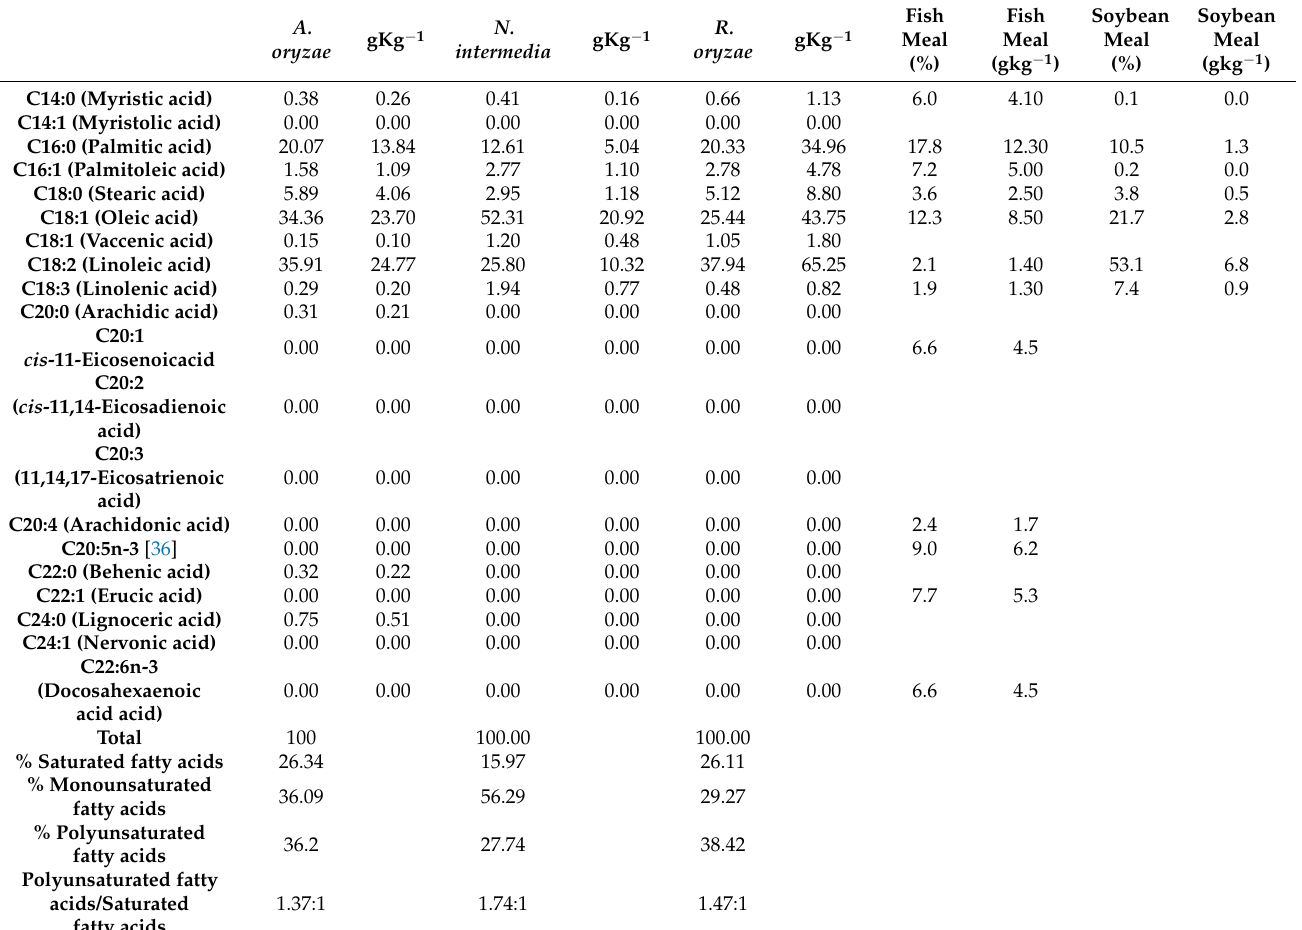
about the optimum level of lipid inclusion in fish and other aquatic animals feed but it is clear that they are needed to provide energy and reduce protein oxidization as an energy source (protein-sparing effect) [16]. It was reported that up to 20% of lipid sources can be easily taken up by a majority of fish [21]. Complex lipids that are the major part of lipid sources contain fatty acids that serve several key roles in the body [32]. According to the data presented in Table 2, linoleic acid (C18:2) (LA), oleic acid (C18:1) and palmitic acid (C16:0) accounted for the highest percentages of fatty acids in all three studied species. The primitive function of different fatty acids is to provide the energy for the organism via oxidation [21]. Table 2. Fatty acid profile of A. oryzae , N. intermedia and R. oryzae , fish meal and soybean meal. Fish meal and Soybean meal [35].